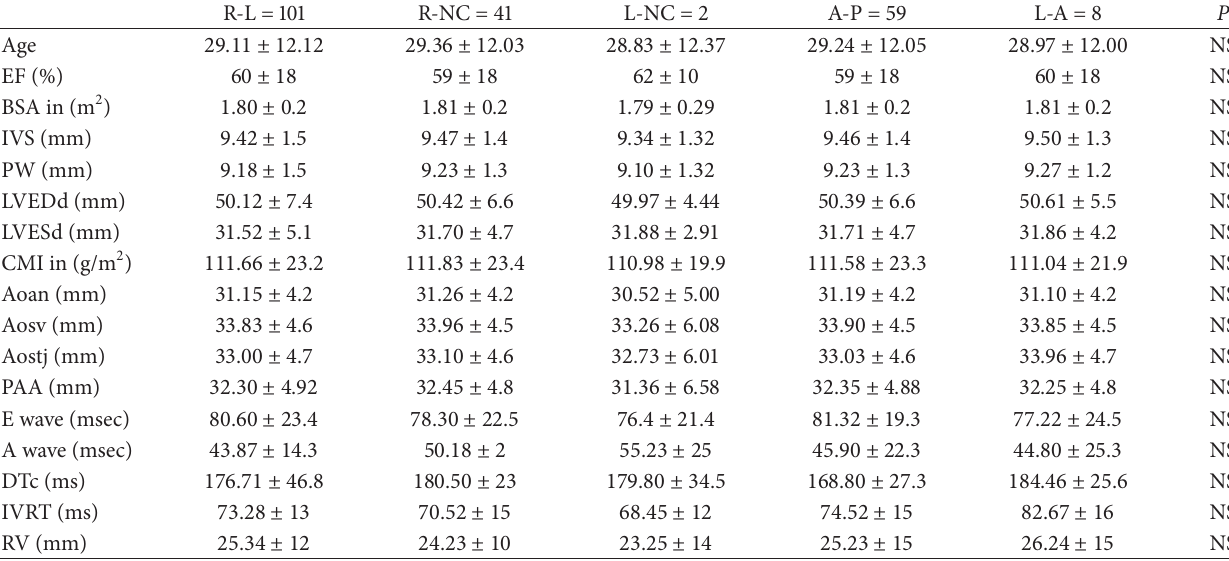
Table 2: Echocardiographic features of the athletes with different types of bicuspid aortic